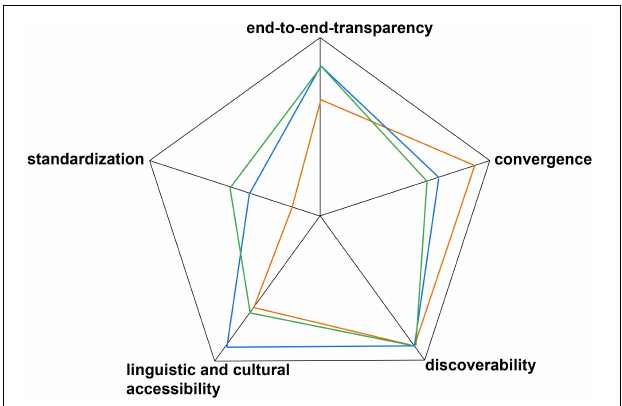
FIGURE 1 | A conceptual spider plot illustrating how different requirement patterns can be visualized against selected criteria that support the Outcomes of the Ocean Decade. The shape of the profiles can vary depending on community needs and priorities, with strands reaching further along a given spoke as priority of the variable increases. In Figure 1 , illustrative, fictional plots for three applications are displayed: hazard response applications (green profile), science investigations (orange profile), or cross-cultural collaborations (blue profile). With shared priorities and frameworks developed during the Ocean Decade, coupled to interoperating MMS, plots such as these can quickly communicate the priorities behind and support development of ocean